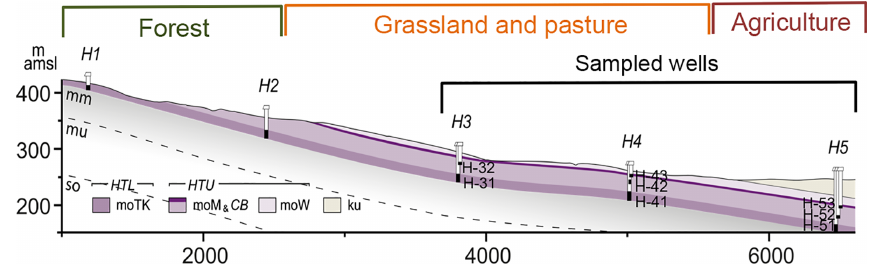
Figure 1. Cross section of the studied Hainich transect. Stratigraphic units moTK, moM, as well as moW represent Middle Triassic units of the Upper Muschelkalk Formation. ku describes Upper Triassic sediments of the Keuper Formation. Sampled wells for this study comprised locations H3, H4, and H5. The lower aquifer assemblage HTL is recharged in the forested area in the upper part of the Hainich mountain range. Aquifer assemblage HTU is recharged in forest, grassland, and agricultural